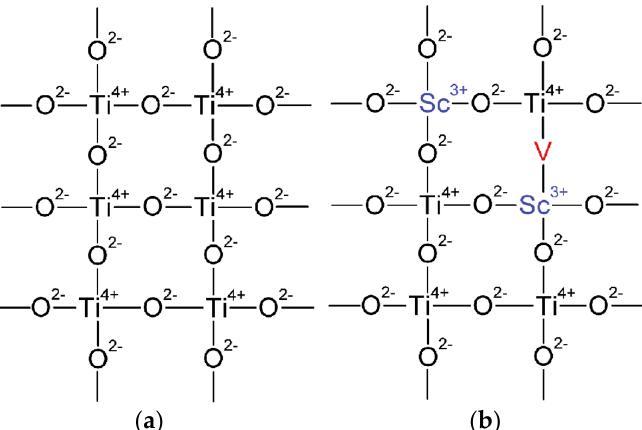
Figure A4 . A schematic illustration of ( a ) TiO 2 and ( b ) Sc-TiO 2 lattices with oxygen vacancies (V) indicated.